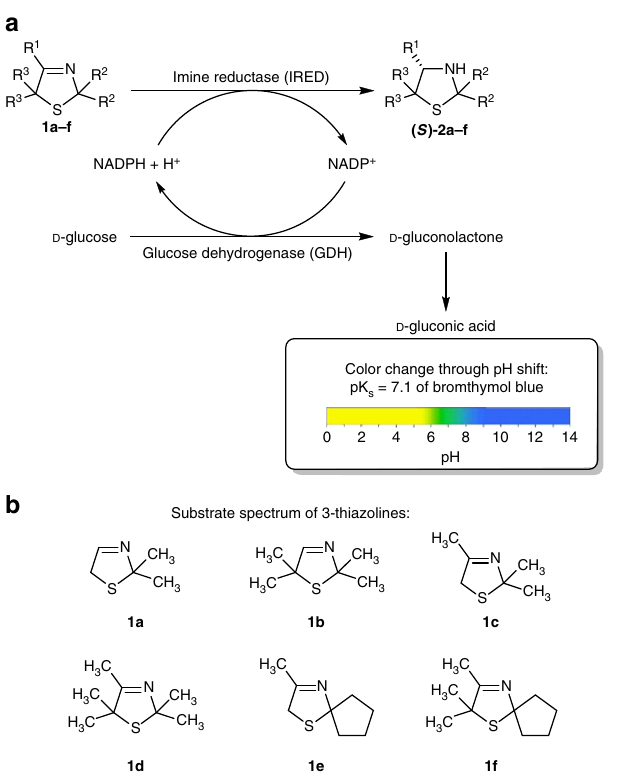
Fig. 3 Colorimetric pH shift assay of 3-thiazolines. a Concept of colorimetric pH shift assay. Reduction of substrate catalyzed by imine reductase (IRED) and in situ-cofactor-regeneration by glucose dehydrogenase (GDH) results in a pH shift, due to formation of gluconic acid. This pH shift is visualized by bromthymol blue as indicator. b